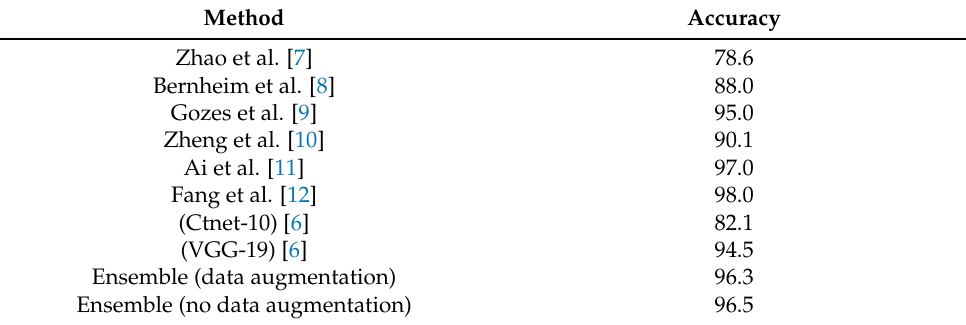
Table 5. Comparison with other